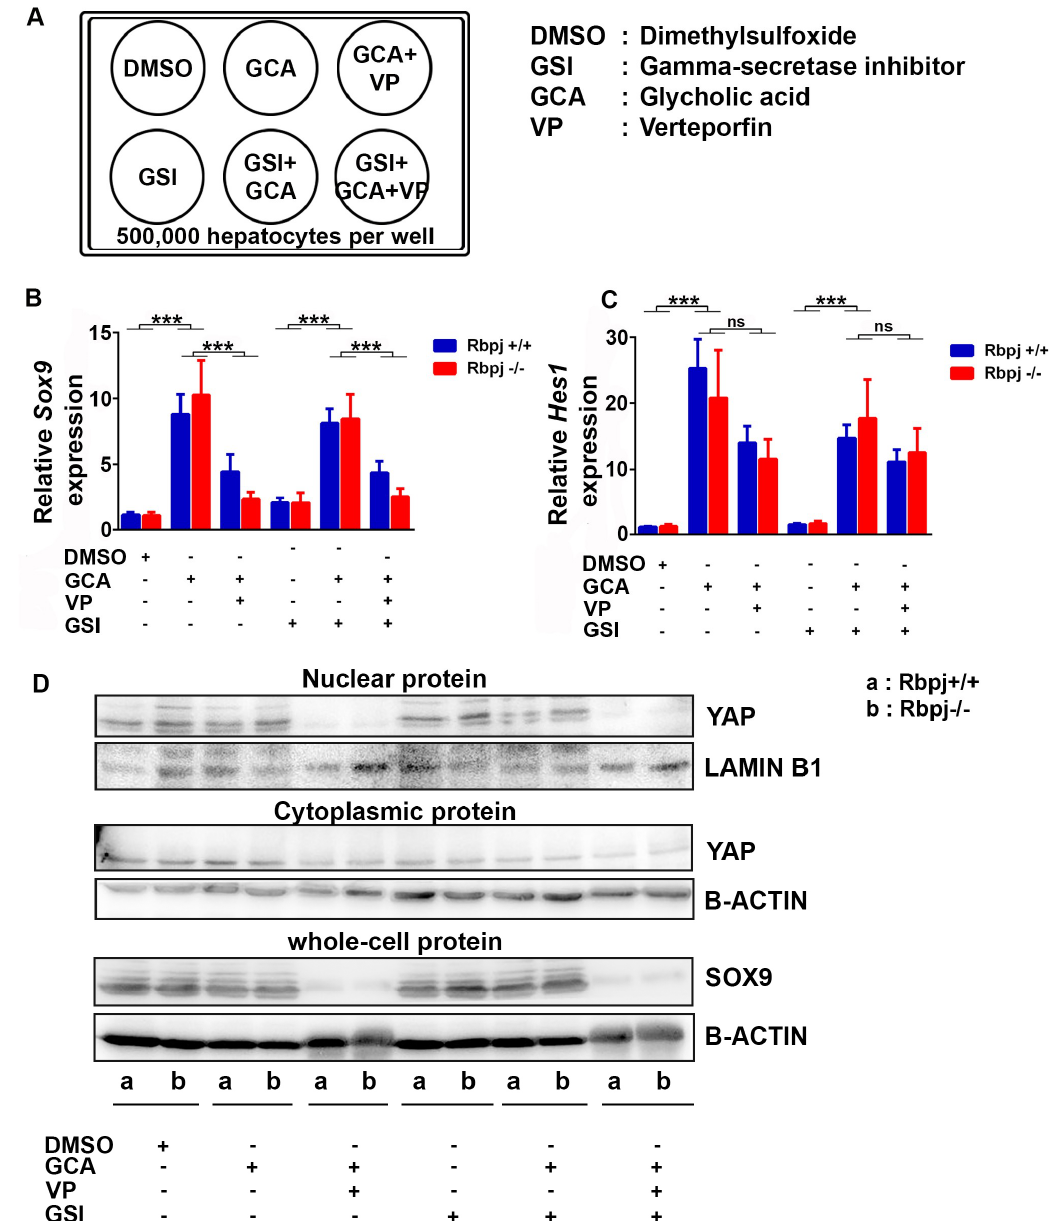
Figure 6. Cholestatic liver injury in vitro results in Sox9 upregulation independent of Notch signalling. ( A ) Scheme for in vitro treatment of hepatocytes isolated from Rbpj +/+ and Rbpj − / − mice. ( B + C ) Bar chart showing relative mRNA expression of Sox9 ( B ) and Hes1 ( C ) normalised to RNA polymerase II ( n = 5–7; *** p ≤ 0.001, ns = not significant; Mann–Whitney test (Two tailed)). ( D ) Immunoblot of nuclear YAP, cytoplasmic YAP and SOX9 from in vitro treated primary hepatocytes isolated from Rbpj +/+ and Rbpj − / − mice. Full-length blot for SOX9 is depicted in Figure S6E .